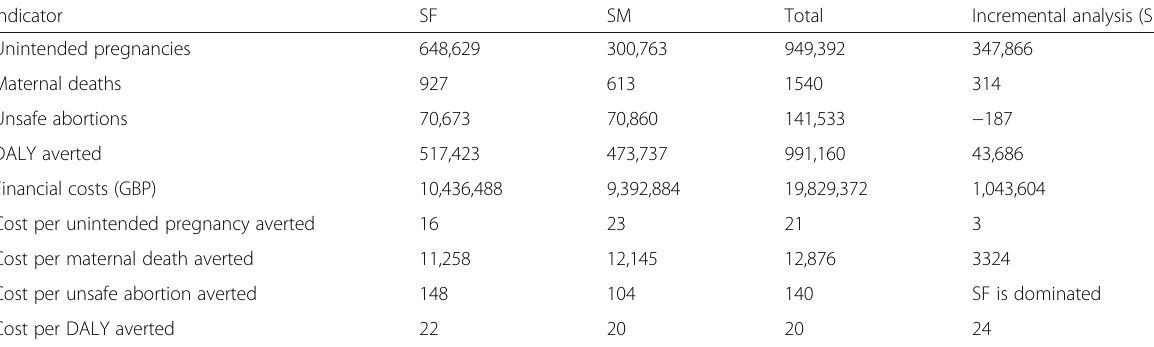
Table 4 Cost-effectiveness indicators for